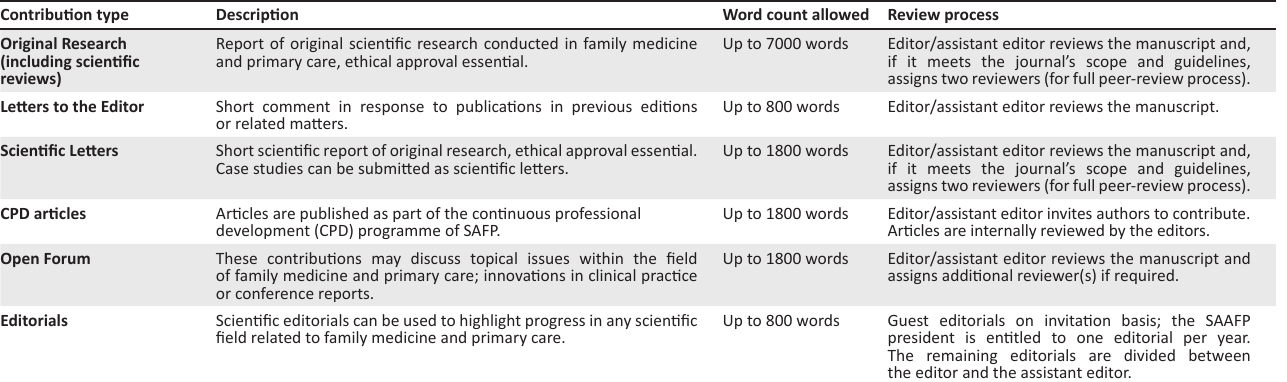
TABLE 1: Revised editorial policy per submission